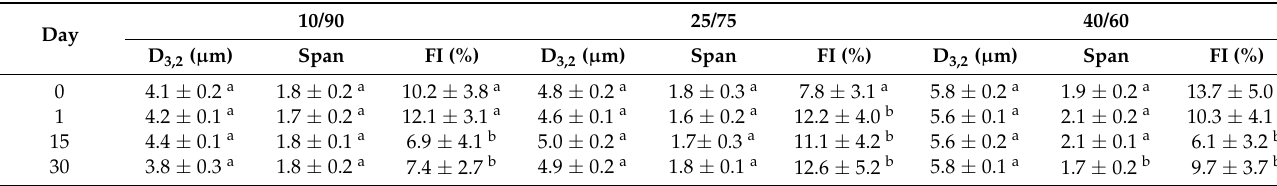
Table 5. Parameters from droplet size distribution (D 3,2 , span and FI) of W 1 /O/W 2 multiple emul- sions obtained after evaluating three different O/W ratios (10/90, 25/75 and 40/60) for the secondary emulsion over 30 days storage time. Different superscript letters within a column indicate significant differences ( p < 0.05).